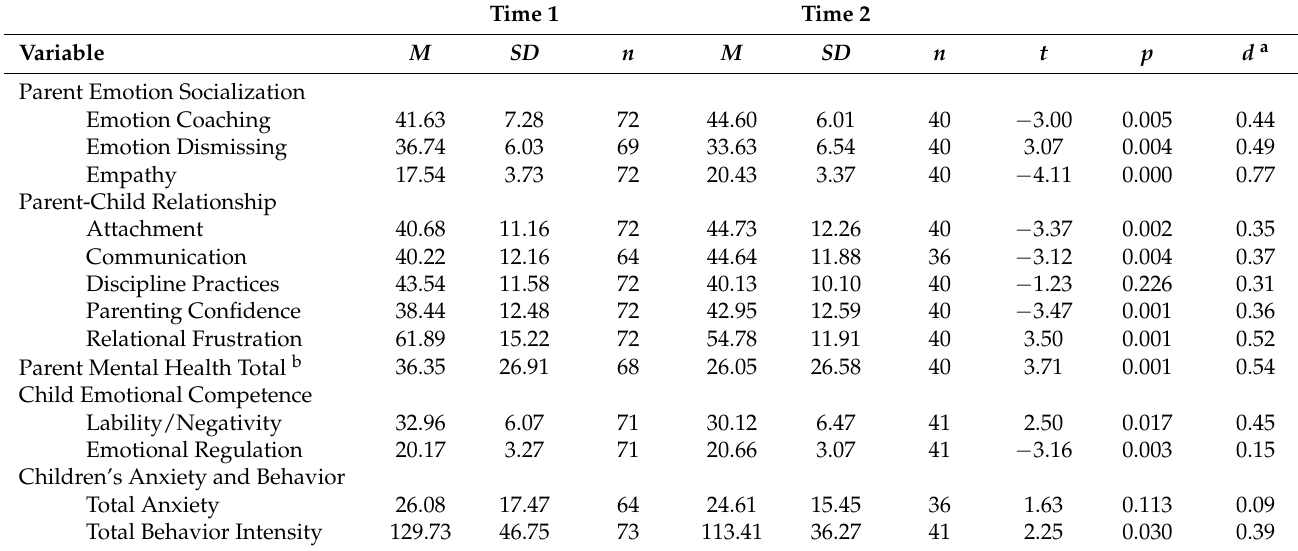
Table 2. Intervention